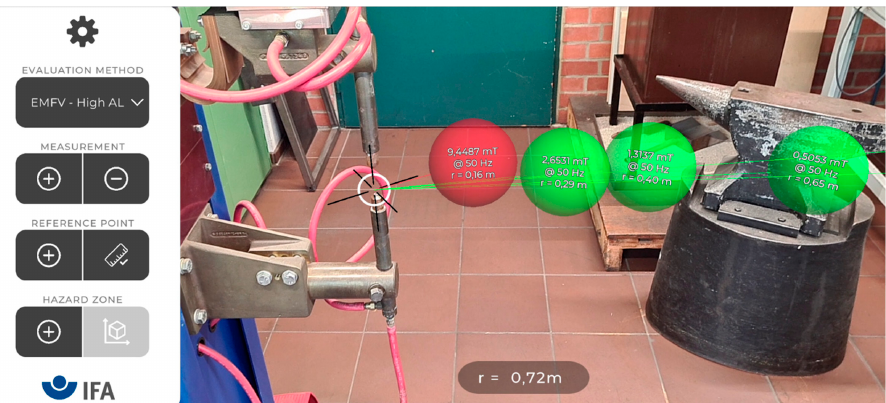
Figure 2. A typical measurement visualization regarding a resistance welding machine. The user interface on the left allows for the addition and removal of measurements (shown as colored spheres), or for the definition of a reference point (the white circle with the black axis). The coloring of the spheres indicates whether limit values are exceeded and depends on the selected evaluation method. The current distance to the reference point is shown at the bottom (e.g., r = 0.72 m). The safety evaluation method can be chosen from a dropdown list containing differ- ent regulations, e.g., for workers with or without a pacemaker [11]. Depending on the active evaluation method, the spheres are color coded to visualize if a measurement is above a certain limit value, in which case the sphere would be red. Figure 3 shows the settings for defining a hazard zone, which represents a volume within which the measurements are above the limit values. In other words, the hazard zone represents safety distances. The zone is textured with half transparent black and yel- low warning stripes, and the edges of the volume are highlighted in black. This rendering allows for good visibility of the hazard zone and provides a good understanding of how it is embedded in the environment. In general, AR objects can be (partially) occluded (due to the depth sensor data), which improves the 3D embedding of objects in the scene [12]. The hazard zone can be rotated around a vertical axis through its center, and its dimen- sions can be adjusted independently in 5 cm steps. This enables the occupational safety expert to quickly visualize the necessary safety distances in a workplace.